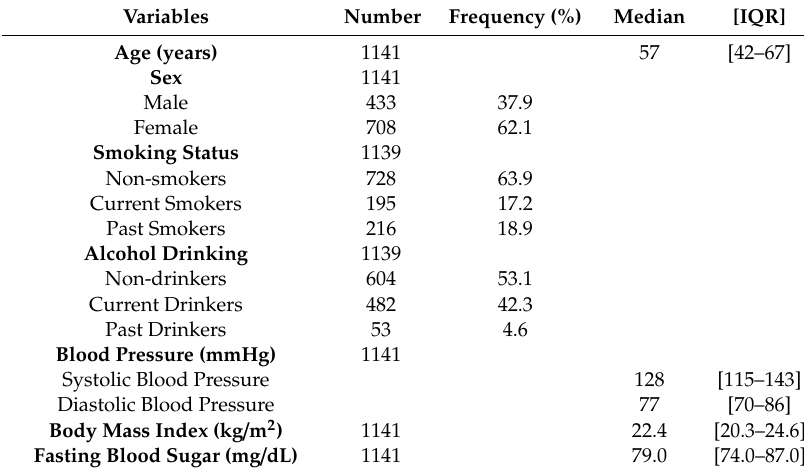
Table 1. General characteristics of participants ( n =